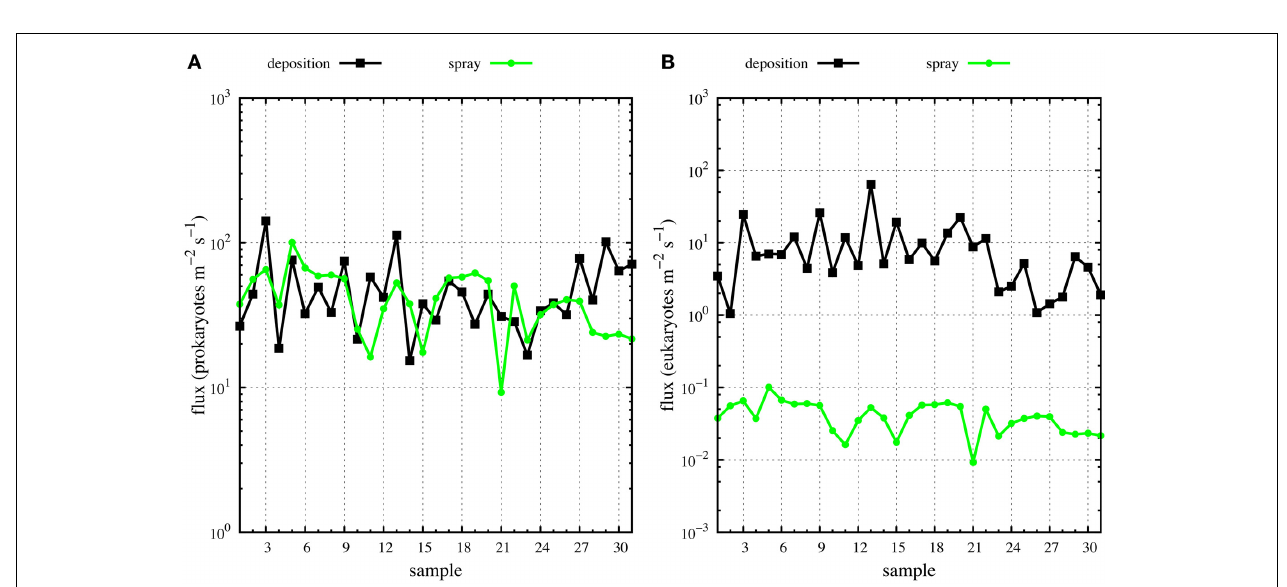
FIGURE 4 | Concentration of airborne prokaryotes (A) and eukaryotes (B) over the eastern North Atlantic along the MEDEA-II cruise.